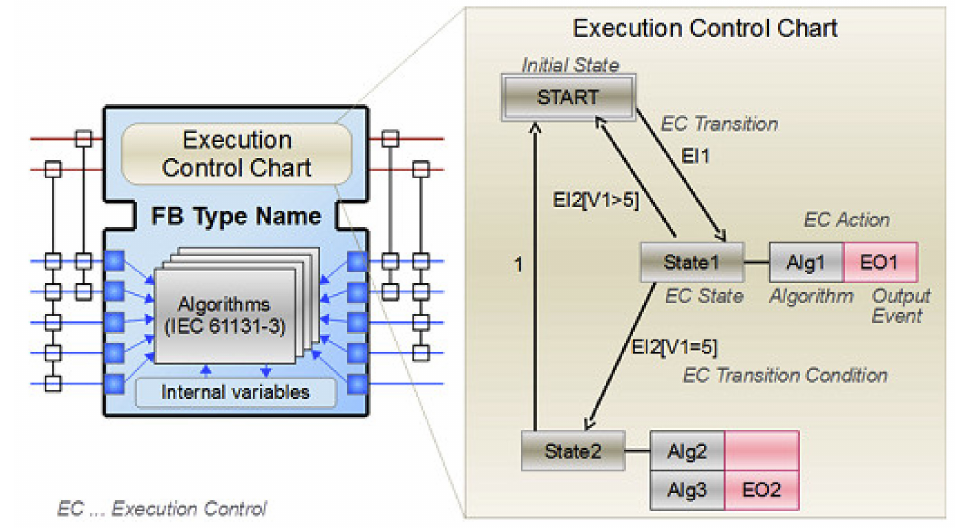
Figure 12. Block structure according to IEC